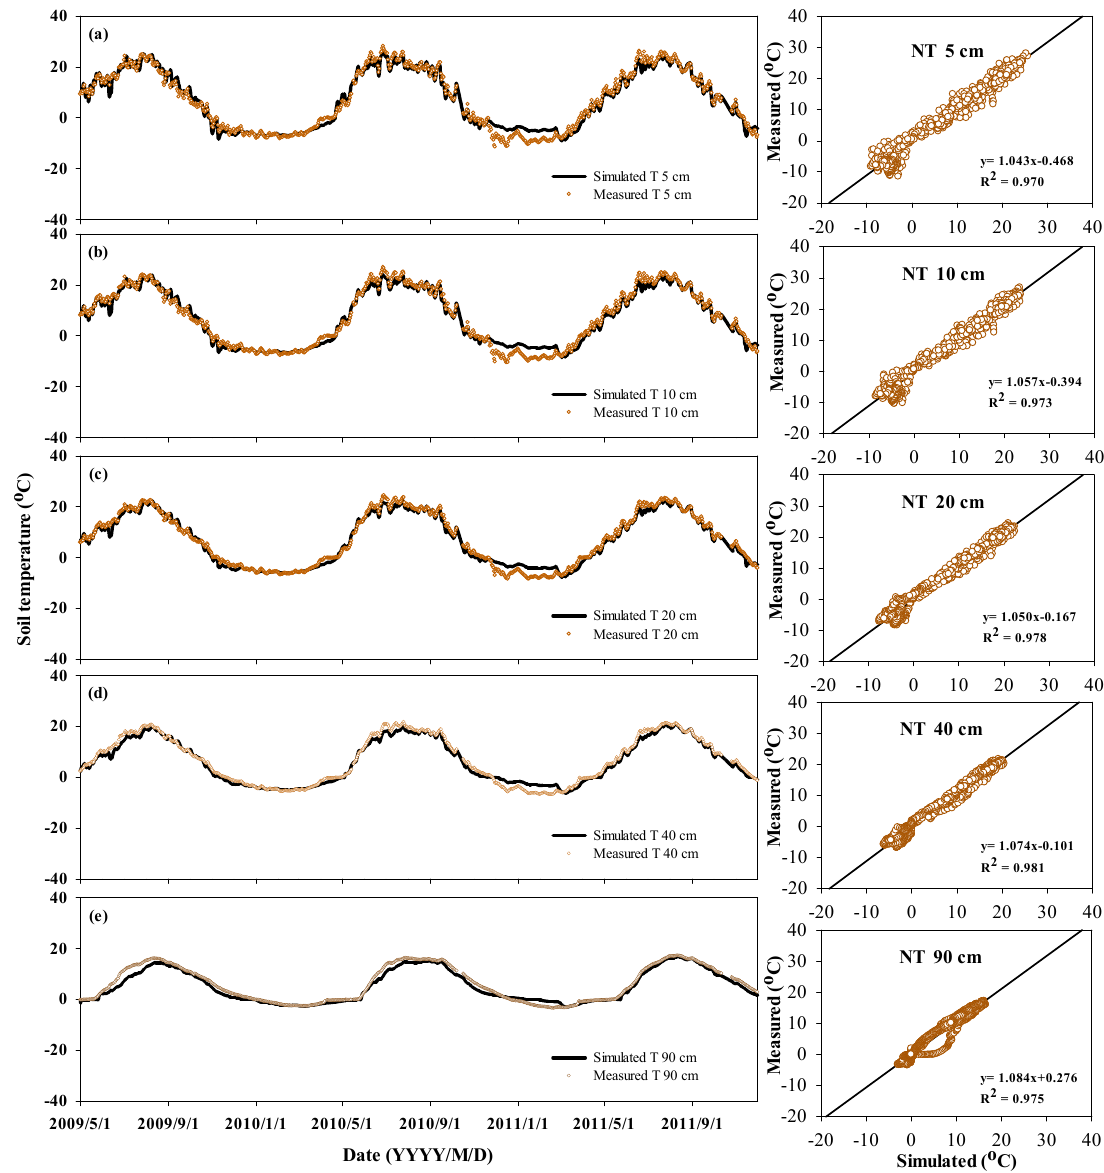
Figure 3. Simulations vs. measurements of daily soil temperatures at ( a ) 5 cm, ( b ) 10 cm, ( c ) 20 cm, ( d ) 40 cm, and ( e ) 90 cm for NT during 2009–2011. Model evaluation using the NT soil temperature produced higher R 2 values ( ≥ 0.97) and lower nRMSE values (22.8% ≤ nRMSE ≤ 30.6%), indicating better agreements be- tween the simulated and measured soil temperatures relative to CT (Figure 3; Table